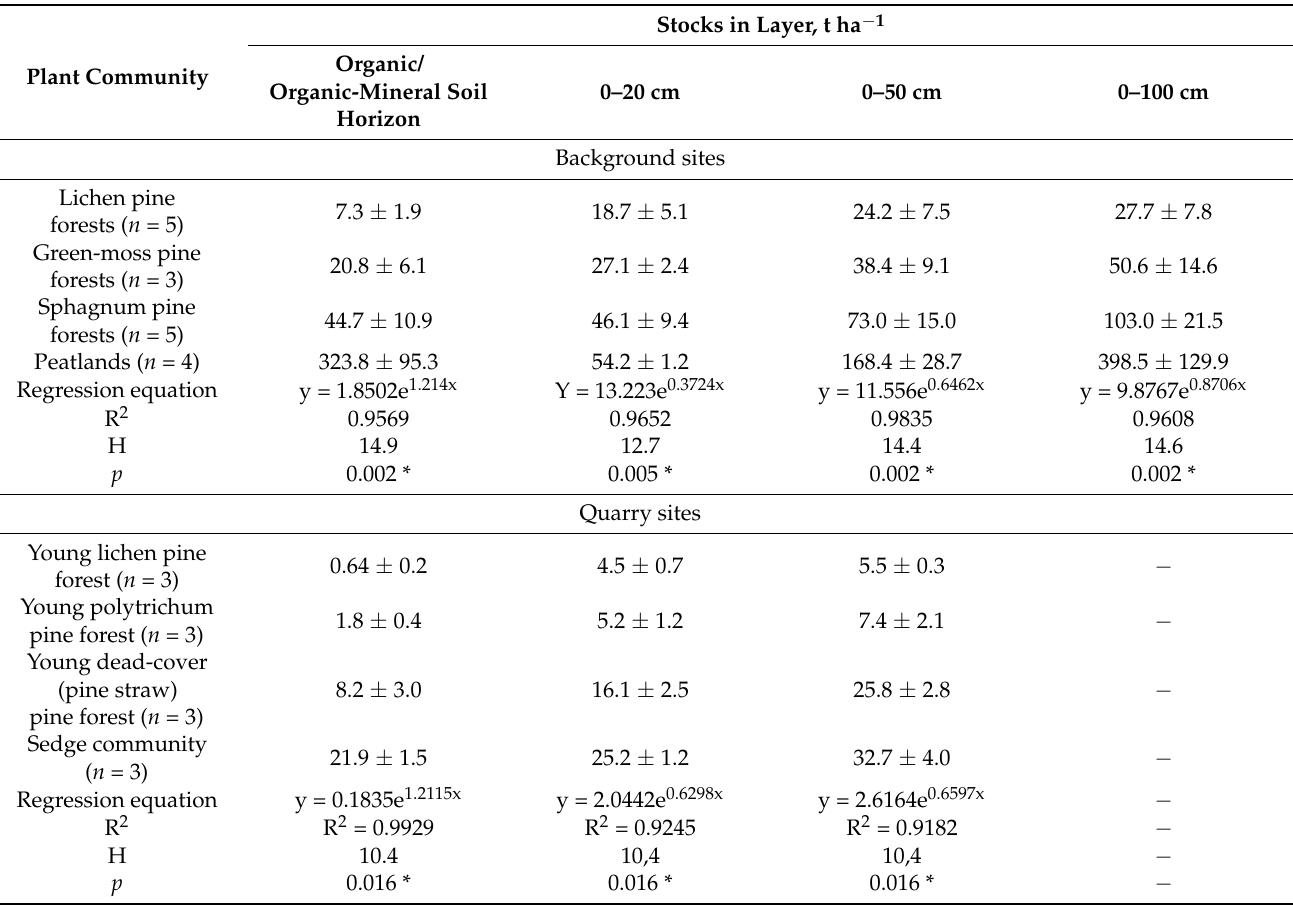
Table 5. Mean stocks ( X ± σ ) of organic carbon in the background and quarry soils, t ha − 1 ; significance of differences (the Kruskal–Wallis